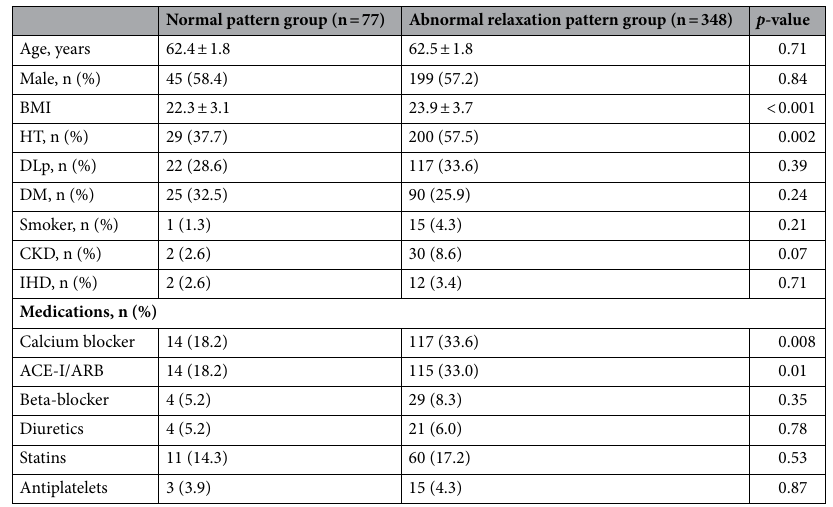
Table 1. Baseline patient characteristics. ACE, angiotensin-converting enzyme inhibitor; ARB, angiotensin II receptor blocker; BMI, body mass index; CKD, chronic kidney disease; DLp, dyslipidemia; DM, diabetes mellitus, HT, hypertension; IHD, ischemic heart disease.